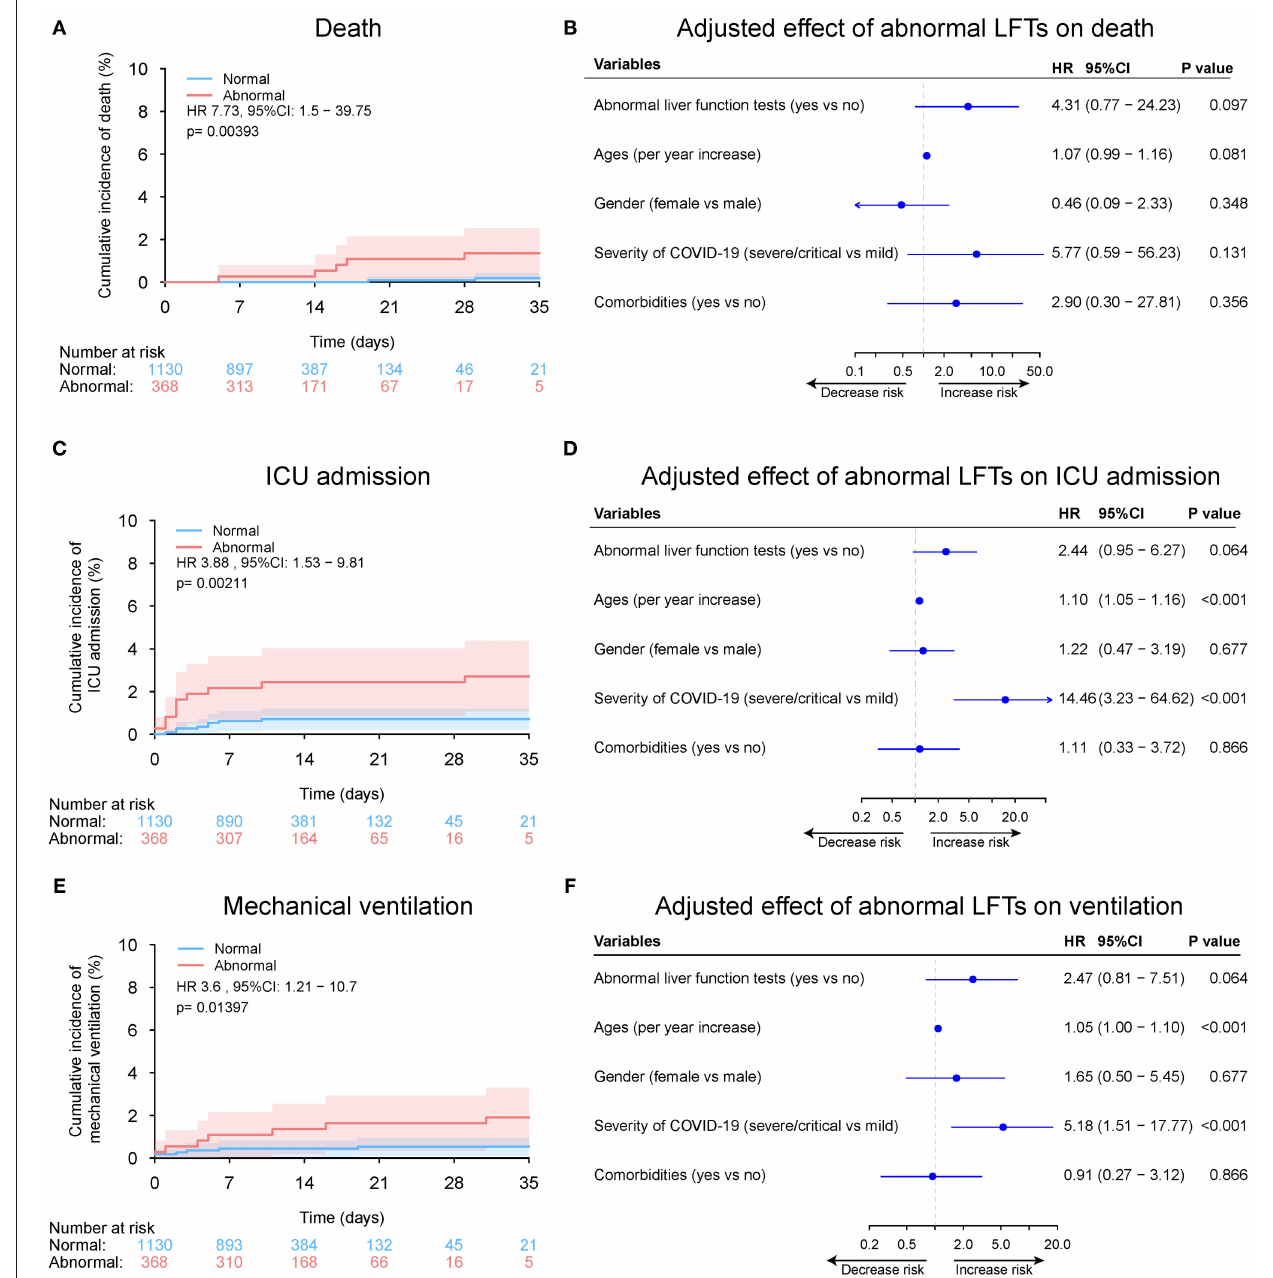
FIGURE 10 | Outcome analysis according to de novo abnormal vs. normal liver function tests (LFTs) during hospitalization. (A) Cumulative incidence of death in patients with de novo abnormal vs. normal LFTs during hospitalization. (B) Independent effect (hazard ratio with 95% confidence intervals) of de novo abnormal vs. normal LFTs during hospitalization on all-cause mortality adjusted for potential confounders using the Cox multivariable regression models. (C) Cumulative incidence of ICU admission in patients with de novo abnormal vs. normal LFTs during hospitalization based on competing risk approach (the Fine and Gray method) with death being the competing events. (D) Independent effect (hazard ratio with 95% confidence intervals) of de novo abnormal vs. normal LFTs during hospitalization on ICU admission adjusted for potential confounders using the Cox multivariable regression models. (E) Cumulative incidence of mechanical ventilation in patients with de novo abnormal vs. normal LFTs during hospitalization based on competing risk approach (the Fine and Gray method) with death being the competing events. (F) Independent effect (hazard ratio with 95% confidence intervals) of de novo abnormal vs. normal LFTs during hospitalization on mechanical ventilation adjusted for potential confounders using the Cox multivariable regression models. Comorbidities include hypertension, cardiovascular disease, diabetes, chronic pulmonary diseases, cerebrovascular disease, malignancy, and autoimmune disease. Chronic liver diseases include hepatitis B virus infection, hepatitis C virus infection, and autoimmune liver disease. LFTs, liver function tests; ICU, intensive care unit.